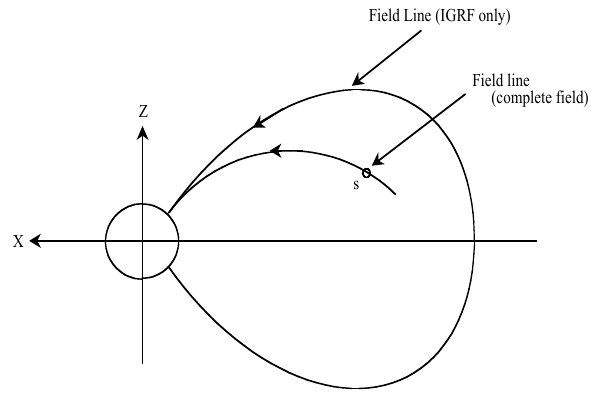
Fig. 1. From the spacecraft location s the field line is traced down to the Earth using the total field (IGRF + external magnetic field). From the conjugate point a field line is traced using the IGRF magnetic field only and the McIlwain L parameter is calculated along this field line for this conjugate point.